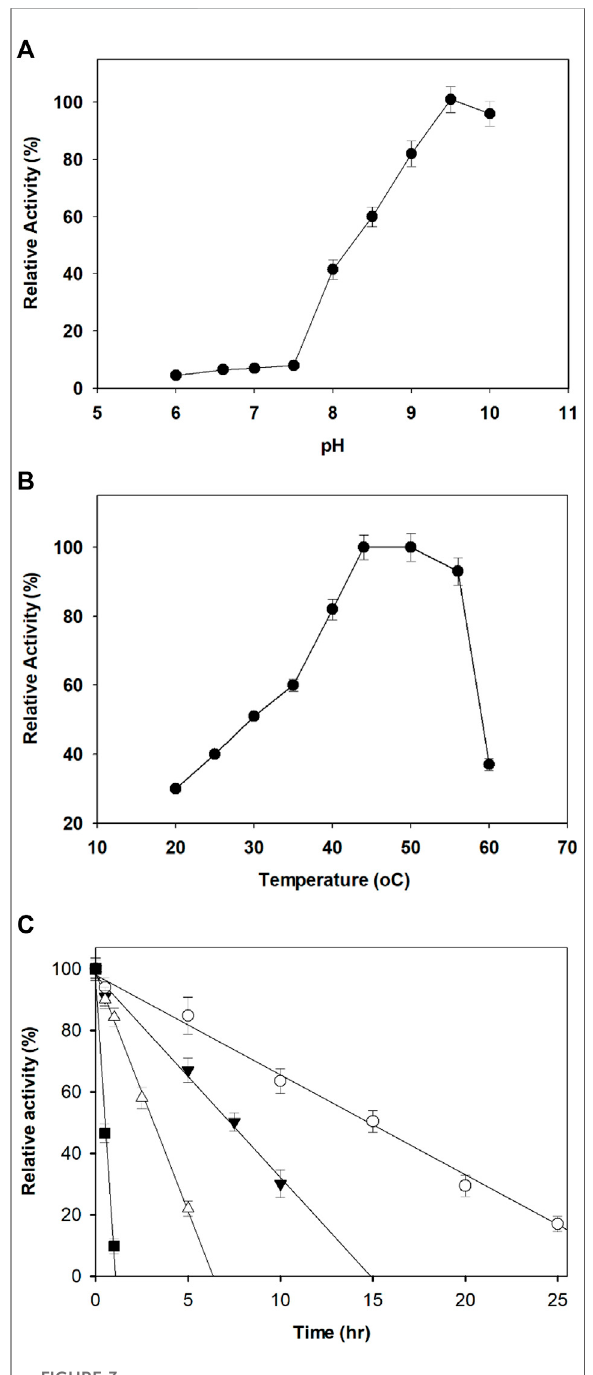
FIGURE 3 Effect of pH (A) and temperature (B) on the activity of AfXDH.